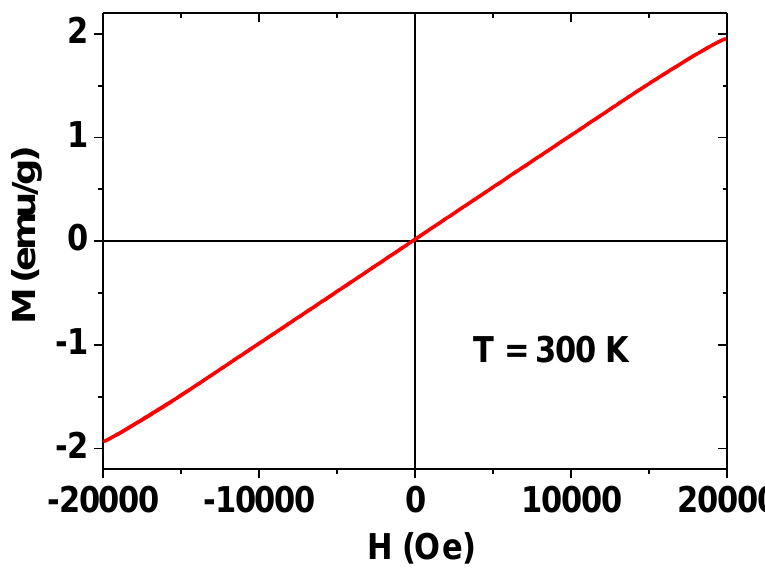
Figure 7. M−H curve at 300 K. Net M value ( i.e., only Gd 2 O 3 nanoparticles without PASA) was es- timated using the net mass of Gd 2 O 3 nanoparticles obtained from TGA and used in the plot.